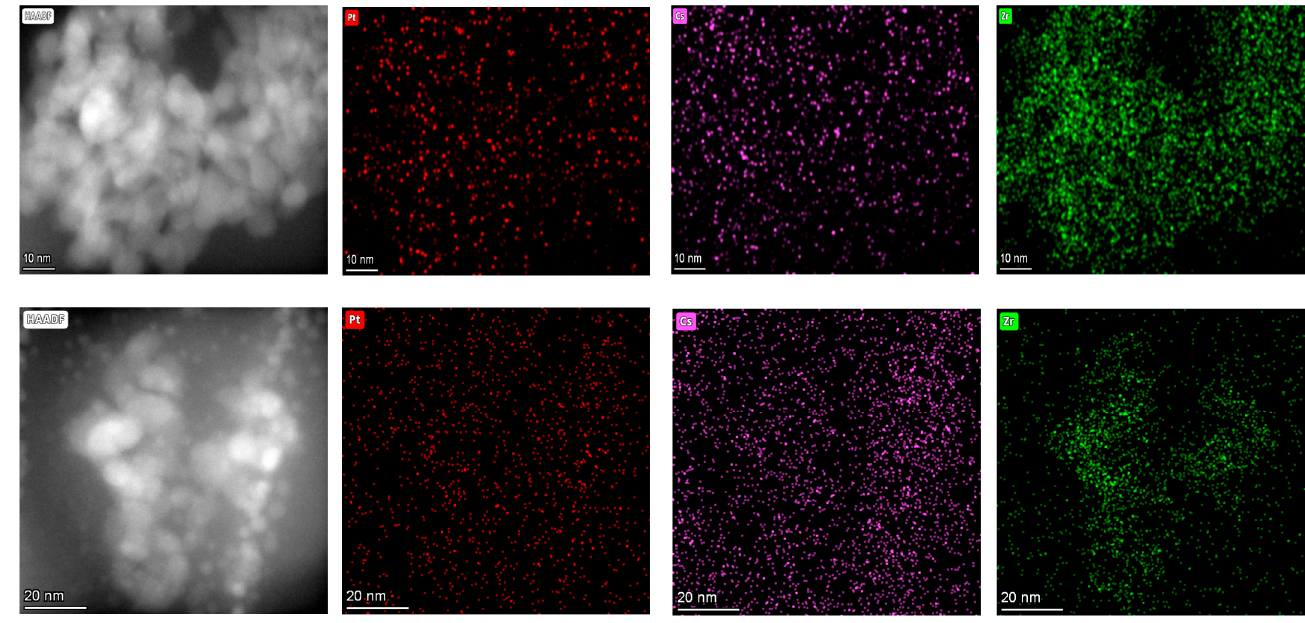
Figure 2. STEM and EDX mapping for ( top ) 2.9% Cs-2% Pt/ZrO 2 and ( bottom ) 14.5% Cs-2% Pt/ZrO 2 (mapping: red for Pt, pink for Cs and green for Zr).